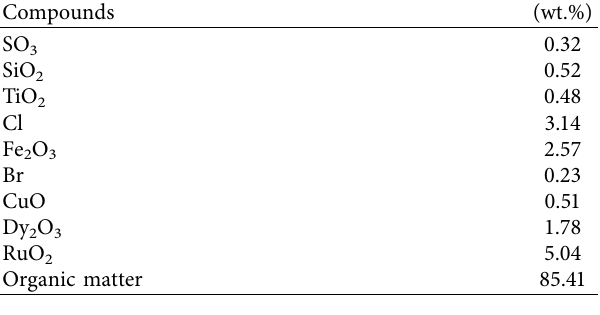
Table 3: XRF analysis of yam peel particulate. Compounds (wt.%)